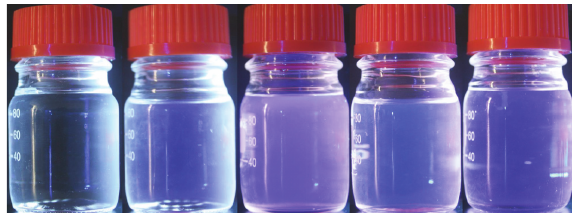
Figure 3: Light is emitted from samples using 250 nm wavelength UV lamp. From left, pure water (H 2 O), S1 (Triton X-100), S2 (CS- 124), S3 (HCO-60), and LAB-based LS. Pure water does not emit light. LAB-based LS is shown for the comparison of light intensity with other